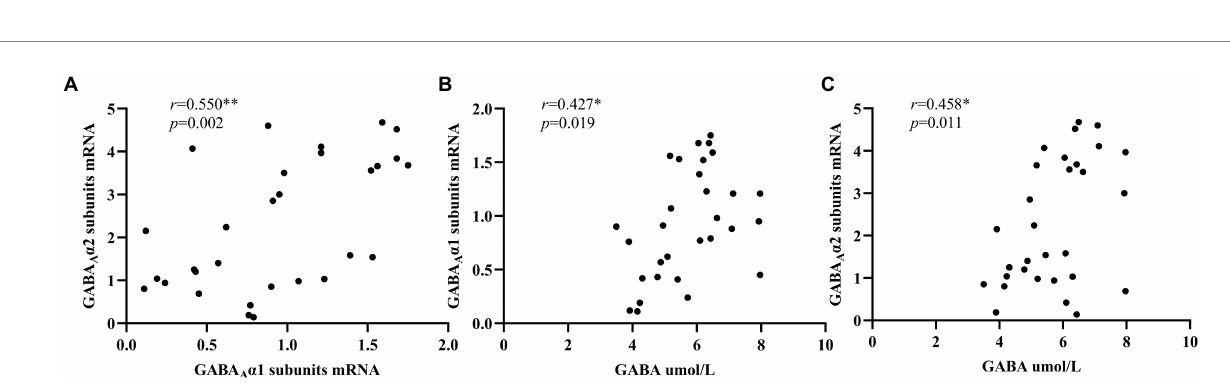
FIGURE 3 Correlation analysis of serum GABA level, GABA A receptor α 1 subunits mRNA and GABA A receptor α 2 subunits mRNA expression levels in the normal control group. 2 – ∆∆ Ct was used to calculate the relative expression of GABA A receptor α 1 subunits mRNAs and GABA A receptor α 2 subunits mRNAs. * p < 0.05. ** p <